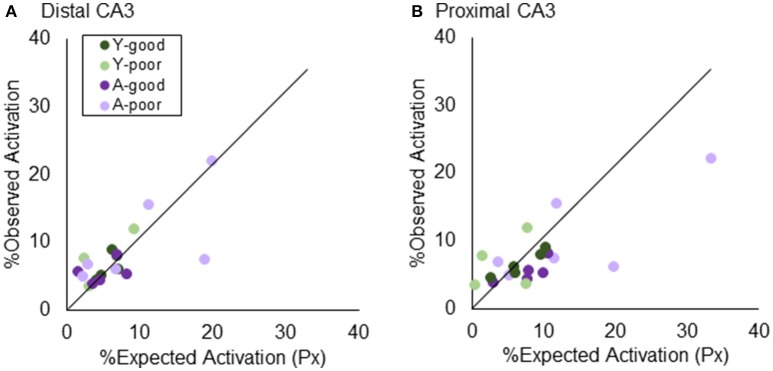
Testing “Uniform Random Draw with Replacement” in CA3. The similarity score assumes that neuronal activity patterns in an environment are randomly selected. Prior results using a thresholding algorithm found that CA3 “under-recruited” neurons. Using stereologically-based quantification, both (A) distal and (B) proximal CA3 did not significantly deviated from the URDWR model.